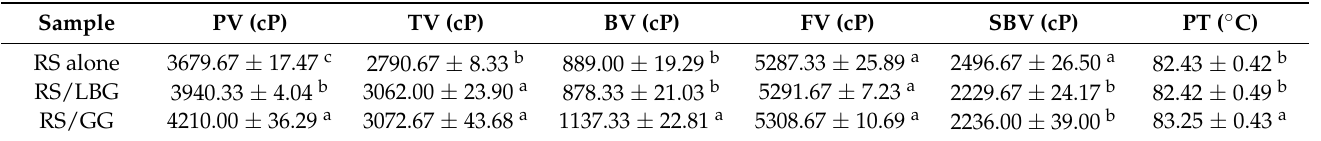
Figure 1. RVA pasting curves of RS alone, RS containing locust bean gum (RS/LBG), and RS containing guar gum (RS/GG). Table 1. Pasting parameters of RS alone, RS containing locust bean gum (RS/LBG), and RS containing guar gum (RS/GG)